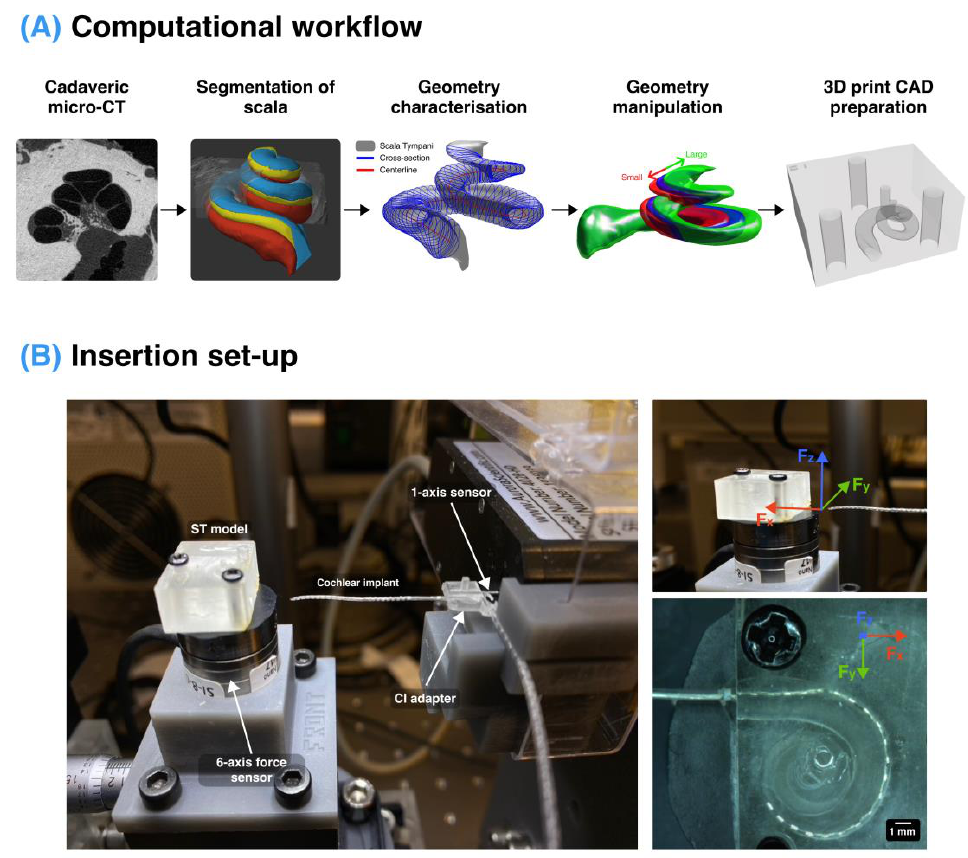
Figure 1. Computational workflow and the custom insertion setup. ( A ) A cadaveric specimen was micro-CT scanned and segmented using Stradview software. The 3D geometry was then characterised in terms of its spiral trajectory and cross-sections using a custom MATLAB script which was used to manipulate the geometry according to each experiment. This generated a 3D file of the ST which was prepared for 3D printing using another custom MATLAB script. ( B ) Insertion setup consists of transparent 3D-printed ST models affixed with screws to a six-axis force sensor placed on a six-axis positioning stage and a CI secured with 3D printed adapters to a one-axis force sensor placed on a stepper motor that moved the CI into the ST model at a defined speed. The setup measures the force on the ST model in the direction of implantation (x), perpendicular in the left and right directions (y), and vertically (z), shown on the right. The one-axis force sensor measured the reaction force on the